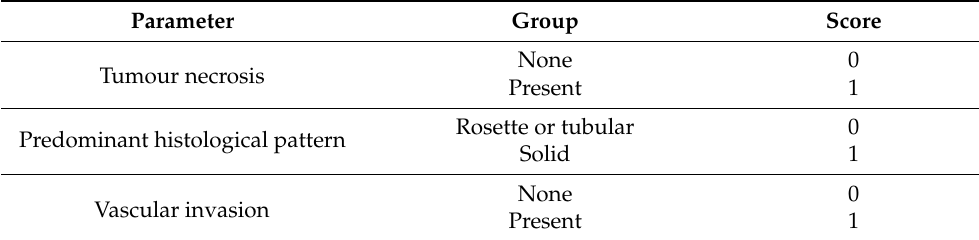
Table 7. Histopathological algorithm to predict survival for dogs with AGASAC.